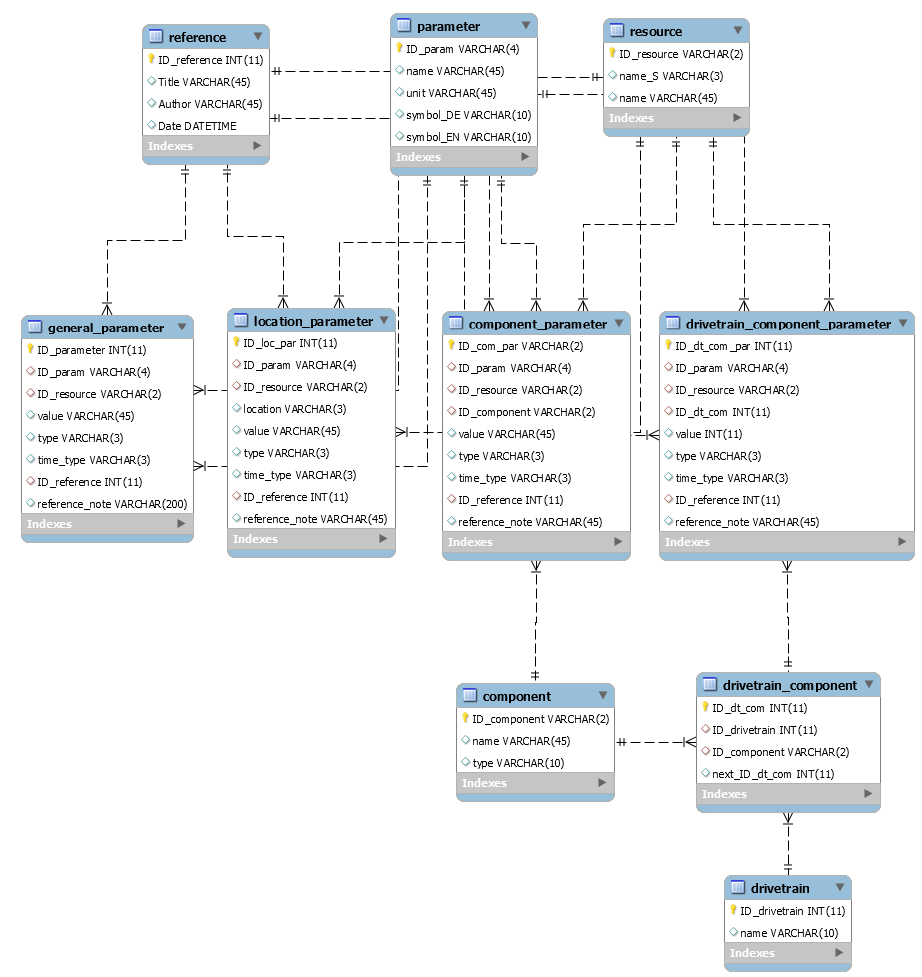
Figure A1. Data scheme of relational database.